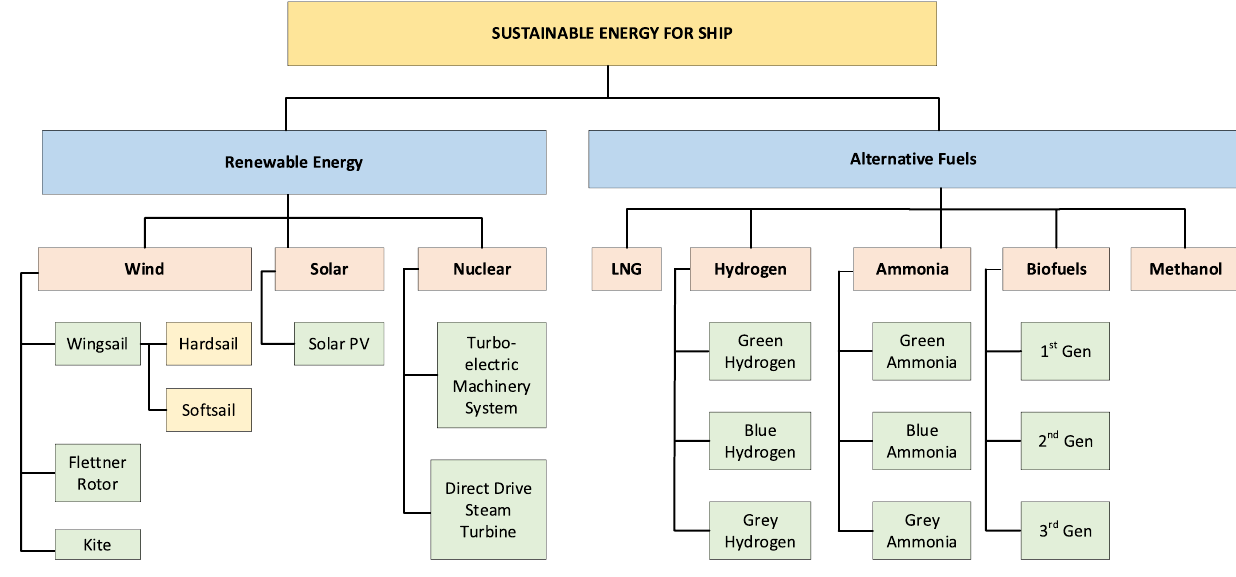
Fig. 16 Types of sustainable energy for